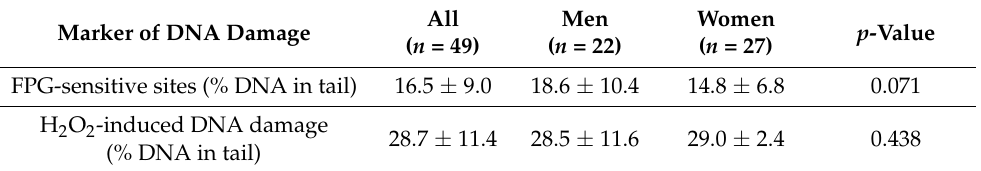
Table 1. Levels of DNA damage markers evaluated at